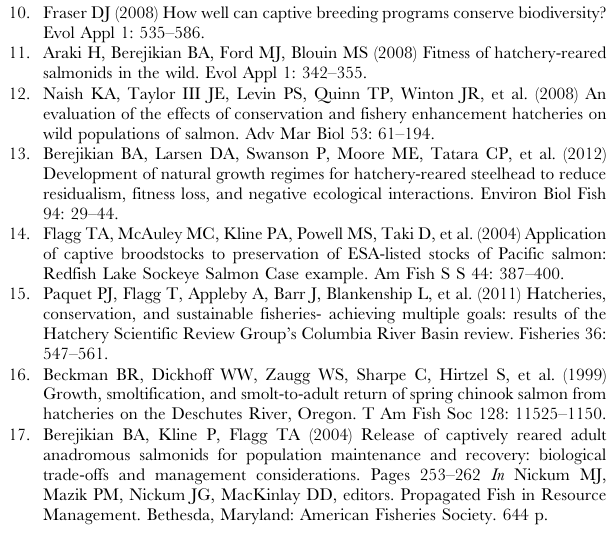
Figure 5. Density plots of wild and hatchery Skokomish smolt migration in 2008. Concentric circles represent the relative number of smolts detected at each acoustic receiver. Larger circles represent a greater proportion of the total number of fish detected in the Hood Canal (8 concentric circles=50%) than smaller circles, which represent a small proportion (1 circle=10%) of the fish in the sample. Plot (A) depicts 2008 Skokomish wild smolt detection densities, and plot (B) shows 2008 Skokomish hatchery smolt detection